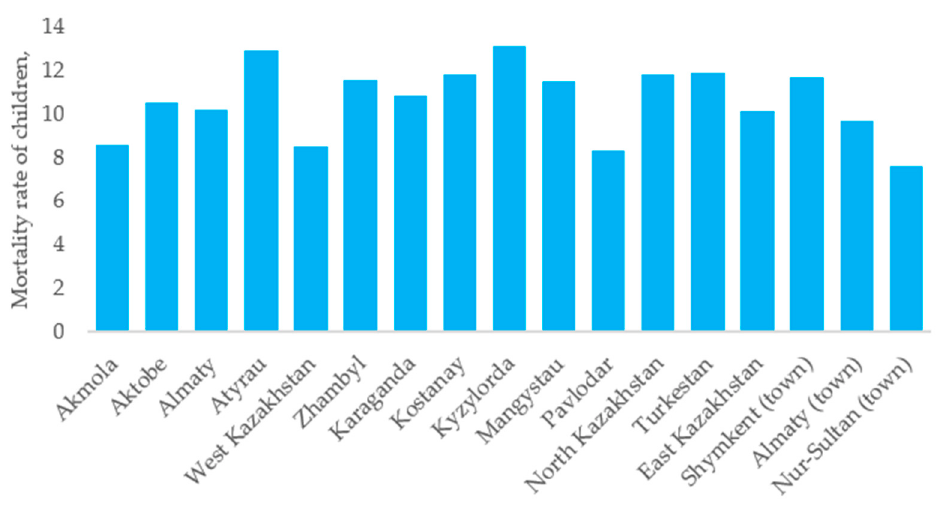
Figure 5. The mortality rate of children under 5 years of age in various regions of the Republic of Kazakhstan (The infant mortality rate is an indicator that measures the mortality rate of infants under 1 year of age (0 years). It is calculated as the annual number of infant deaths under 1 year of age per 1000 births). Source: Bureau of National Statistics of the Agency for Strategic Planning and Reforms of the Republic of Kazakhstan. Available online: https://stat.gov.kz/ (accessed on 26 May